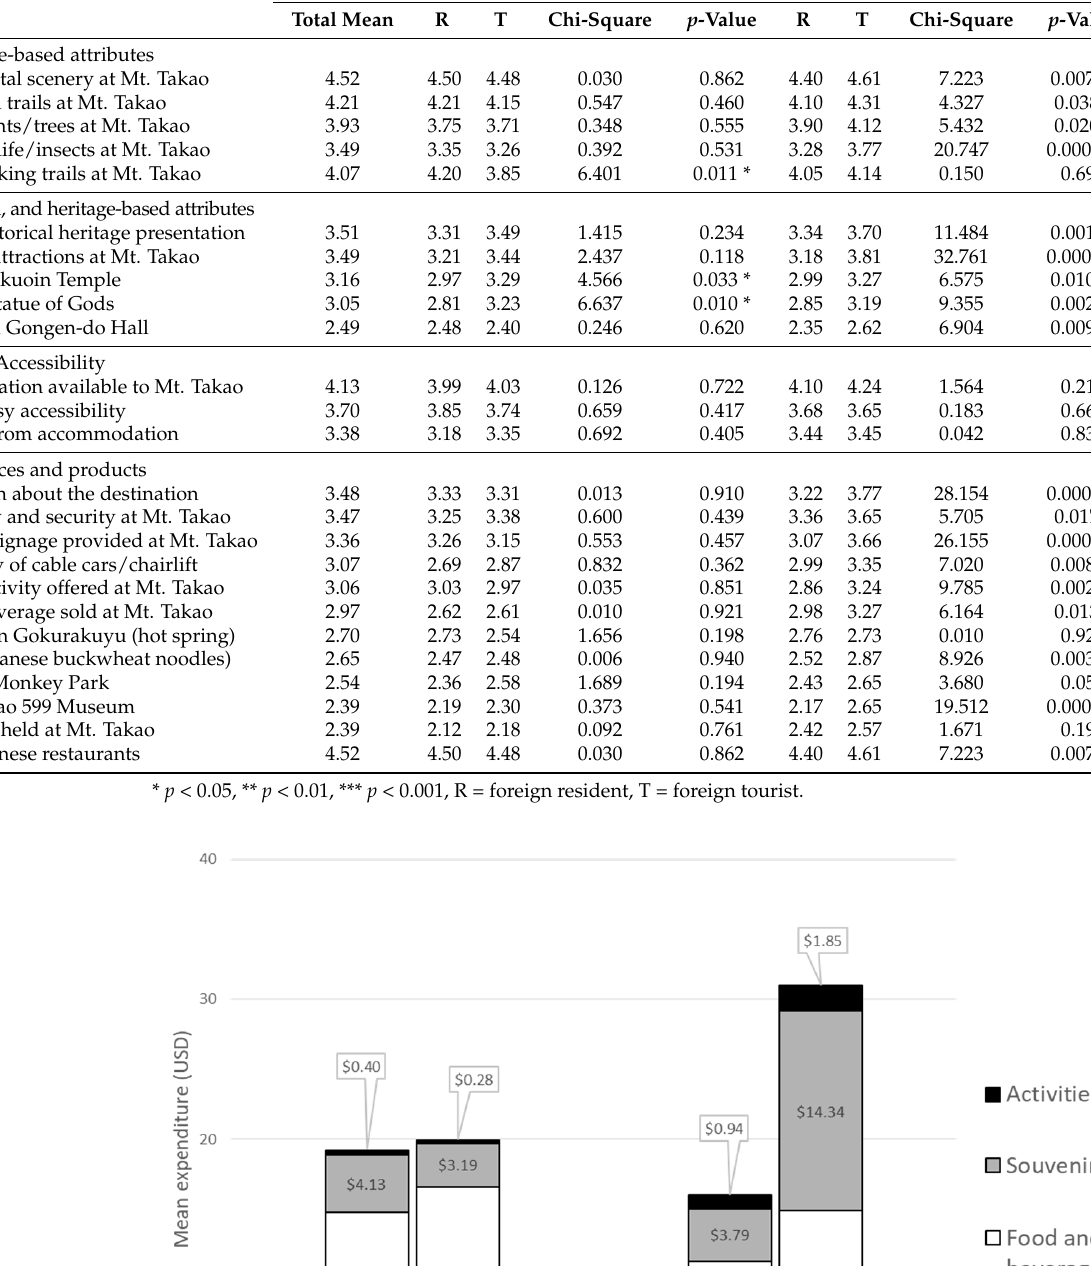
Table 2. Mean perceived importance for 25 attributes for foreign resident visitors and foreign tourist visitors. Type of Attraction Low Season Peak Season Total Mean T Chi-Square p -Value T Chi-Square p -Value